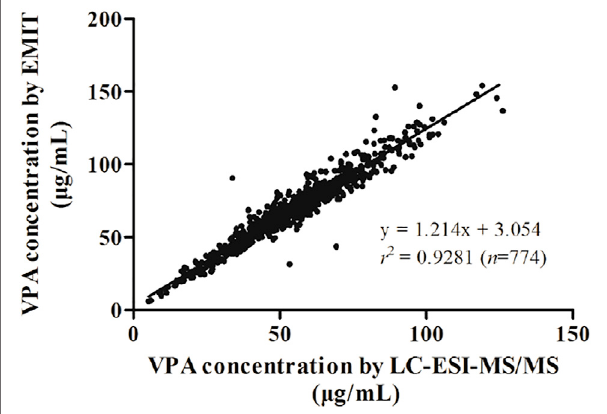
FIGURE 1 | Correlation of the regression curve for LC-ESI-MS/MS and EMIT assay ( n (cid:2) 774).